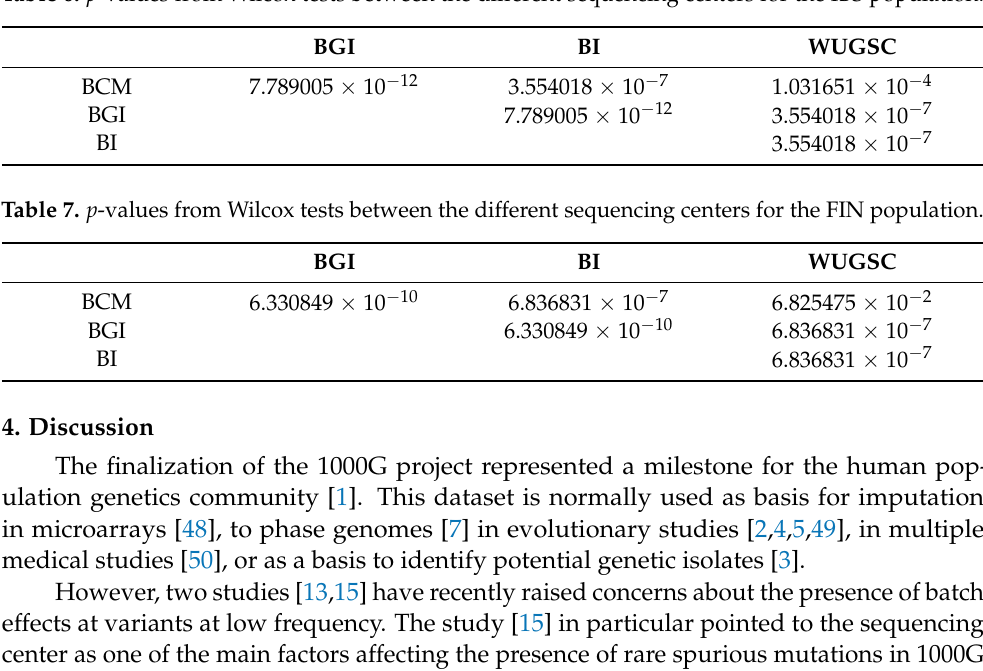
Figure 8. Number of loss of function (LoF) variants by sequencing center in FIN, IBS and SEP populations. In the x -axis the name of the population is displayed; in the y -axis the number of LoF SNVs per individual is displayed. FIN = 1000G Finland; IBS = 1000G Iberian; SEP = Spanish Eastern Pyrenees. Table 6. p -values from Wilcox tests between the different sequencing centers for the IBS population.